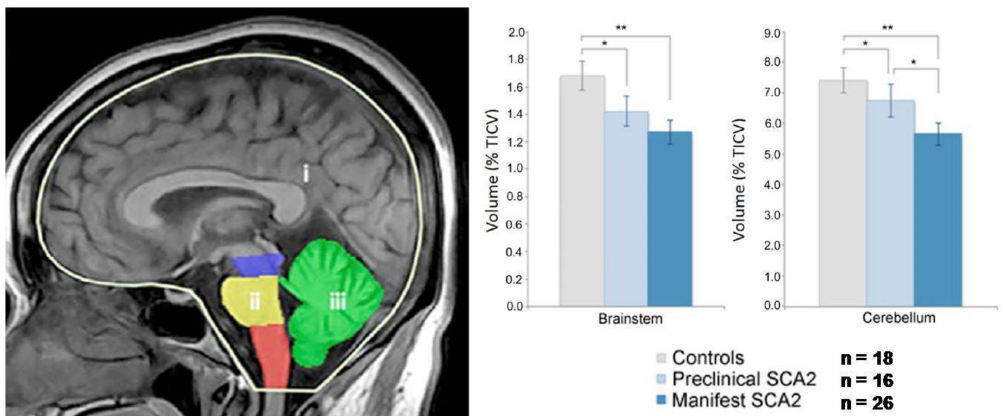
Figure 3. Volumetry in preclinical and manifest SCA2 gene carriers. The volumes of the brainstem (ii) comprising the mesencephalon (blue), pons (yellow) and medulla oblongata (orange), and the cerebellum (iii) (green), both normalized to the total intracranial volume (TICV) (i) (left panel), are significantly (** = p < 0.0001 and * = p < 0.05) lower in manifest and preclinical SCA2 gene carriers than in controls (right panel). Modified fromReetz K., Rodr í guez-Labrada R., Dogan I, Mirzazade S.,